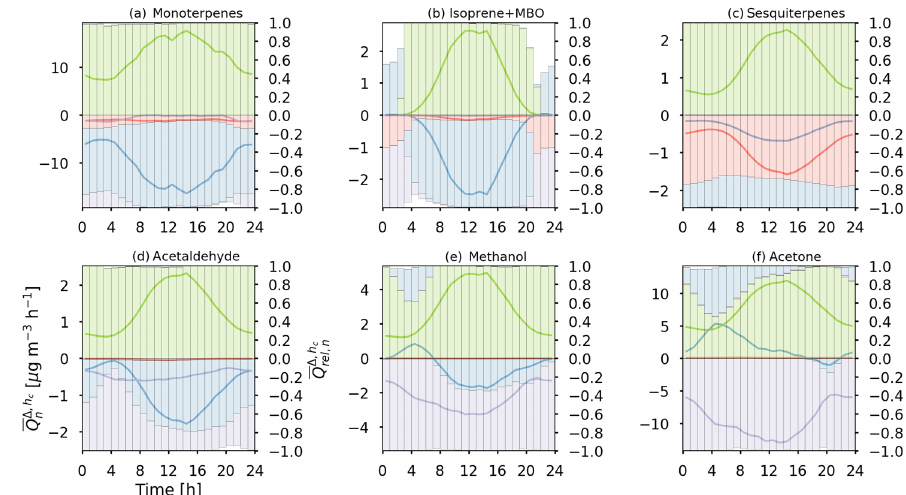
(cid:49),h c (cid:49),h c n (solid lines) and the relative contributions Q rel ,n (bars) of gas emissions